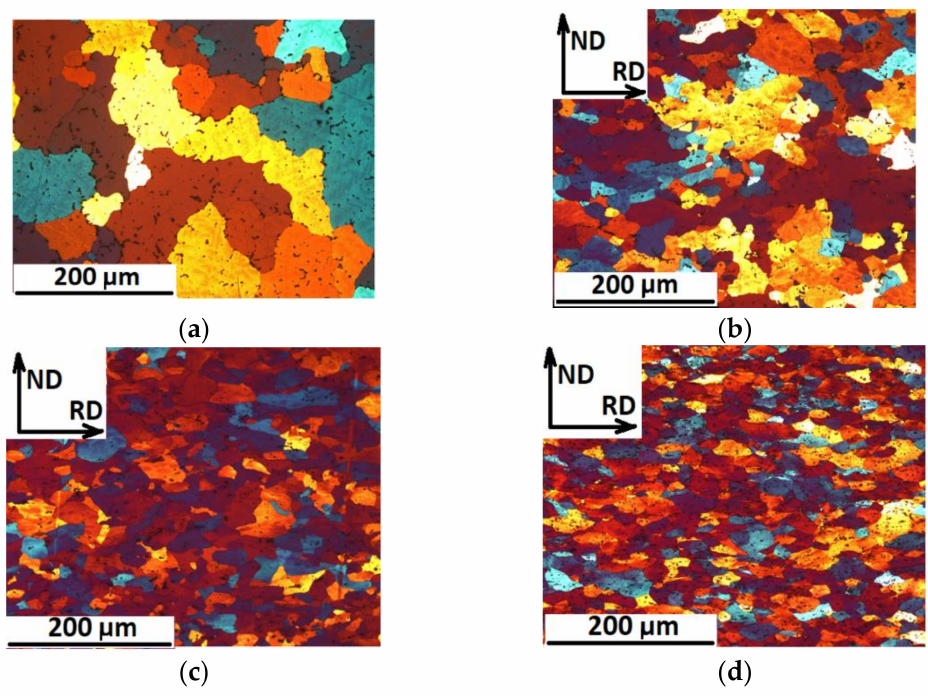
Figure 2. Microstructure of 5182 alloy specimen: ( a ) cast specimen, ( b ) 33.23% deformation, ( c ) 68.47% deformation, ( d ) 83.83% deformation.